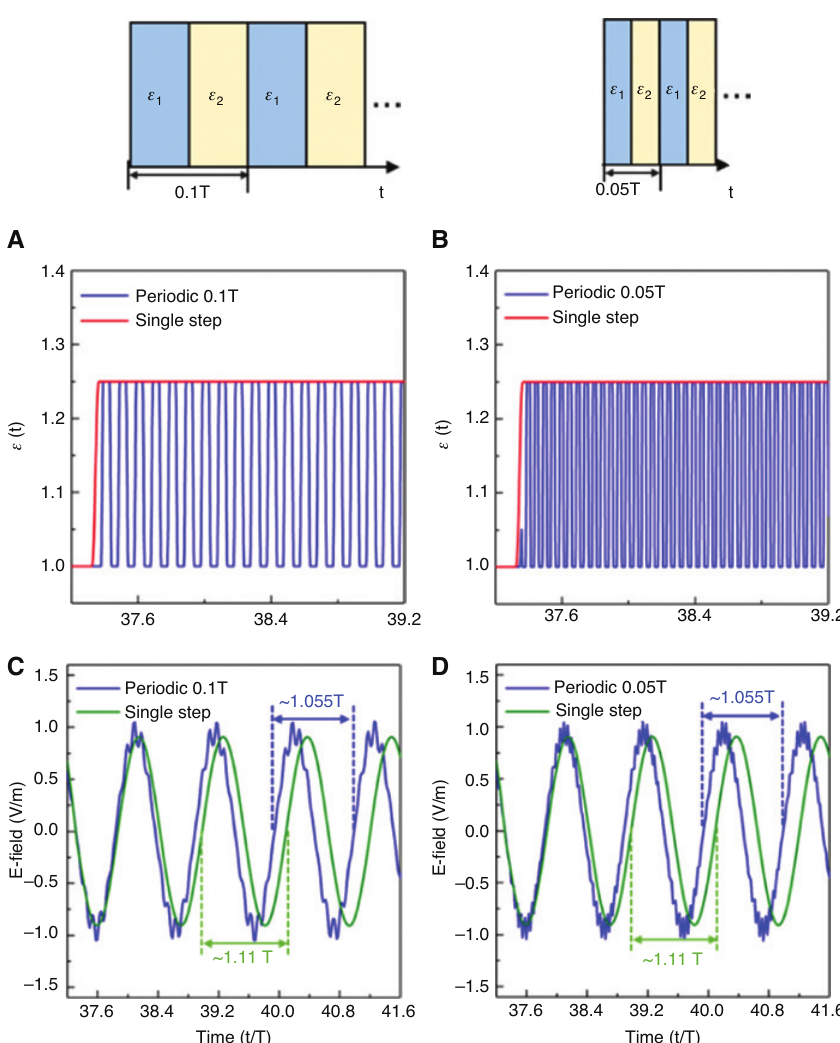
= ε and ε ) and a single step of ε (t) (from ε to ε ). 1 2 1 eff 2